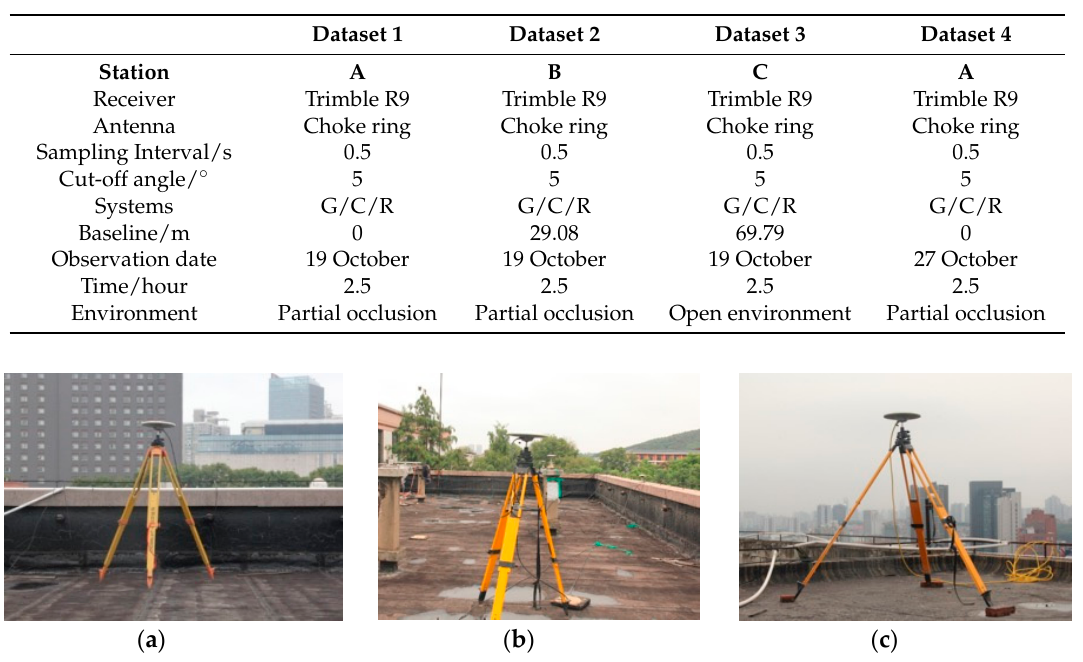
Table 1. Details of the datasets.